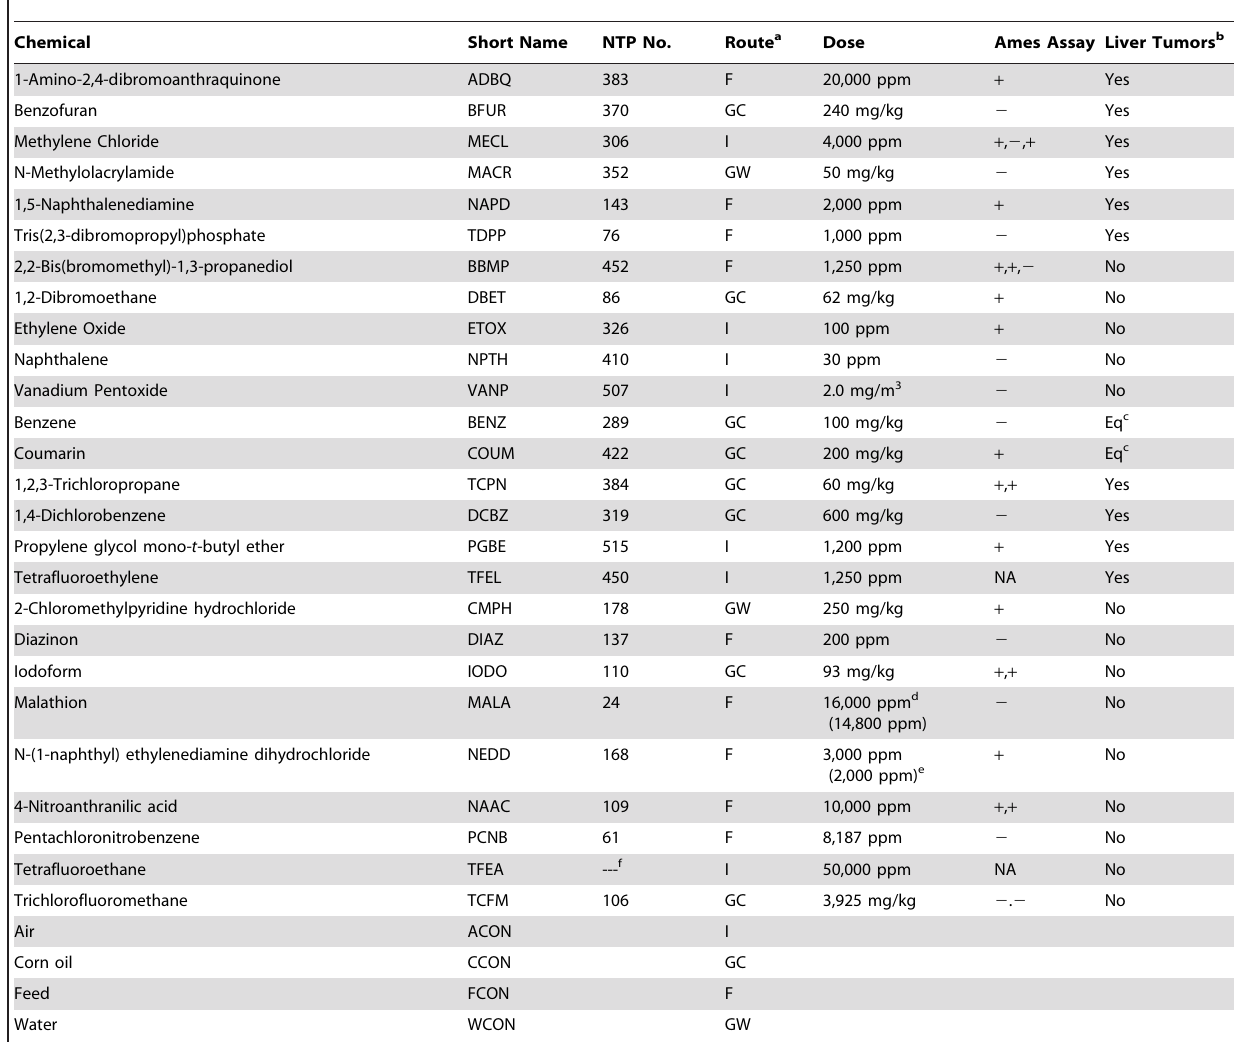
Table 1. Treatment groups and abbreviations used in the 90 day exposure to the 26 chemicals and corresponding vehicle controls used in this